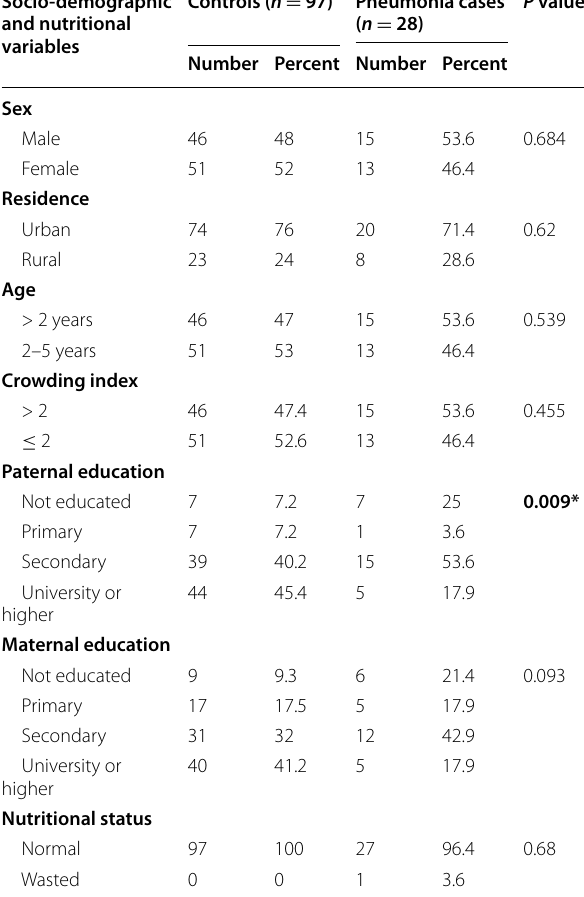
Table 4 Comparison between pneumonia cases ( n controls ( n 97) regarding the socio‑demographic factors =